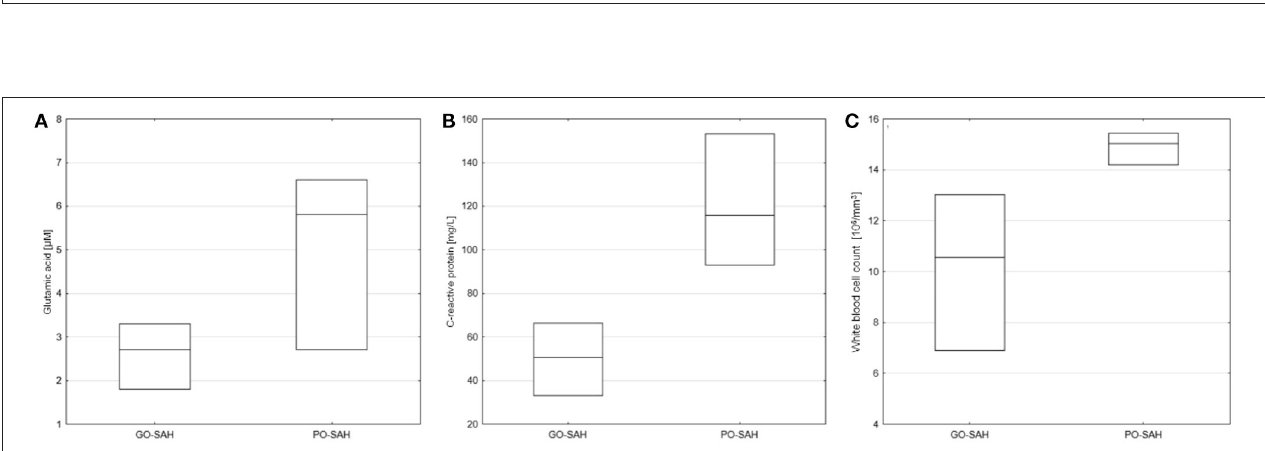
FIGURE 2 | Significant differences in monitored parameters on day 5 post-SAH between patients with good (GO-SAH) and poor (PO-SAH) treatment outcome. (A) T -Student test revealed significantly higher levels of glutamic acid ( p = 0.041) in patients with poor outcome. Mann–Whitney test revealed significantly higher C-reactive protein level ( p = 0.020) (B) and white blood cell count ( p = 0.044) (C) in patients with poor outcome. In all cases median levels and the 25th and 75th percentile are presented.